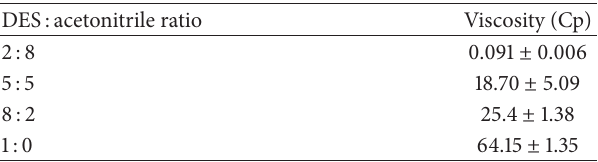
Table 4: Viscosity of DES binary solvent systems at different ratio of DES :